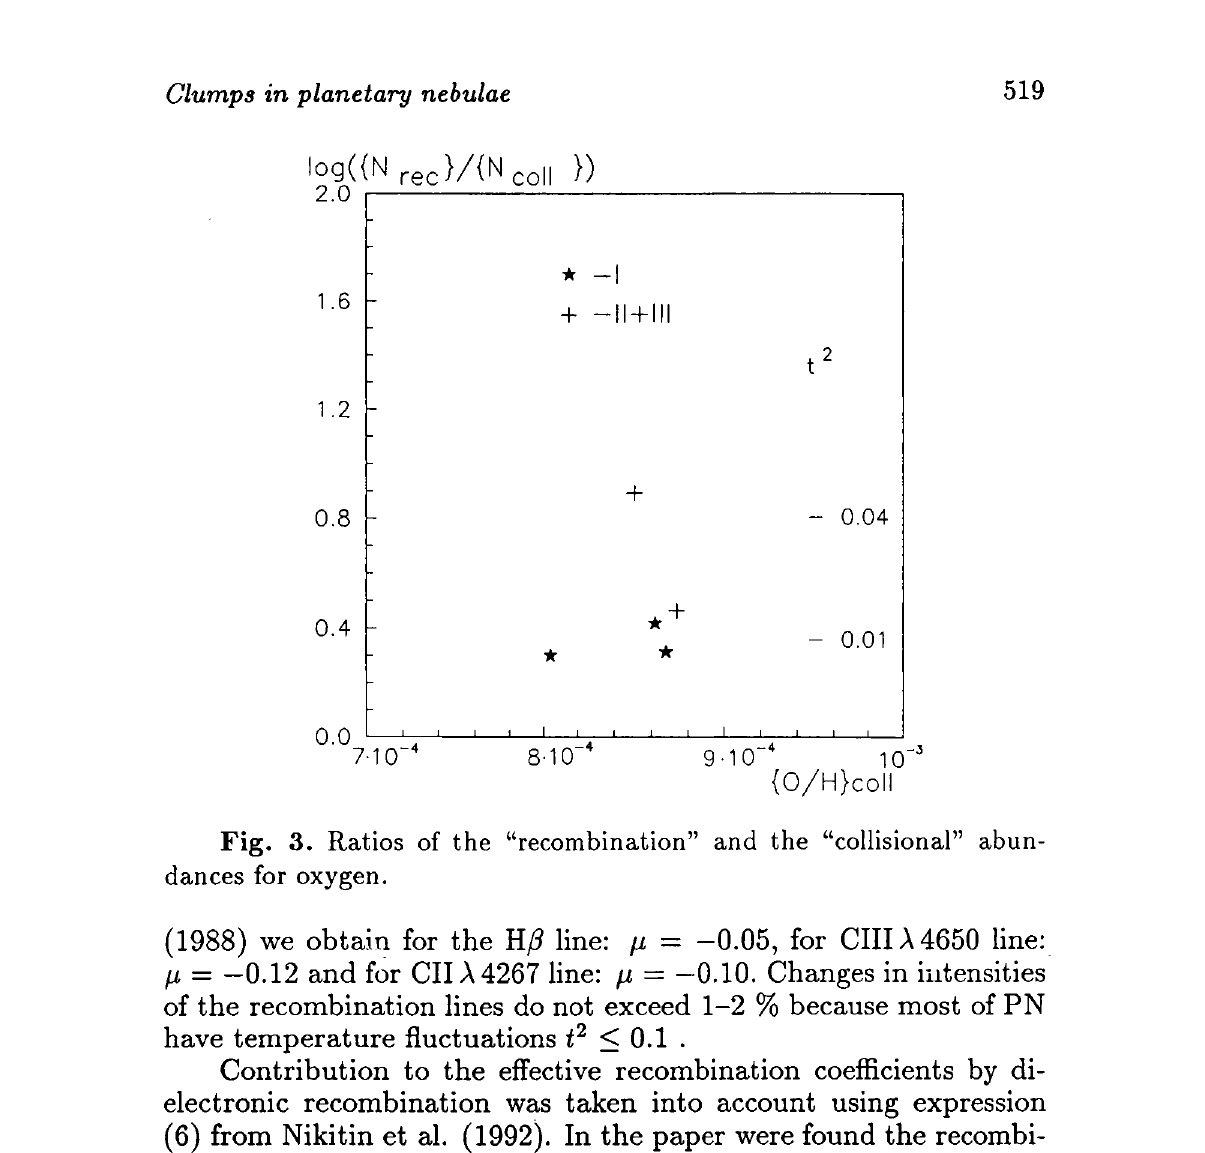
Fig. 3. Ratios of the "recombination" and the "collisional" abun- dances for